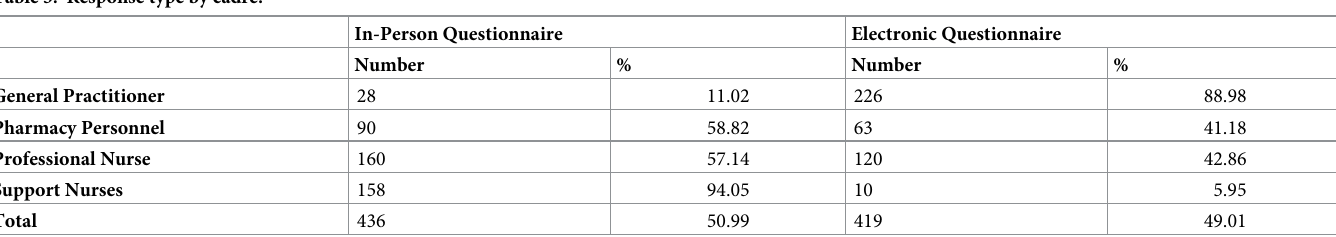
Table 3. Response type by cadre.